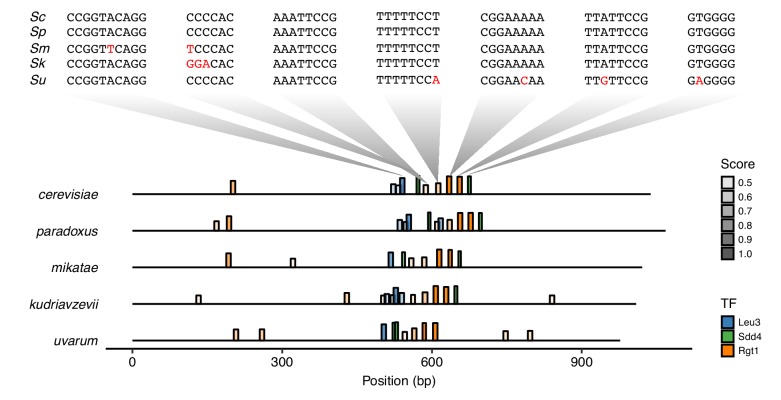
Conservation of TF motifs in HAS1pr-TDA1pr.Position of Leu3, Sdd4, and Rgt1 motifs (at least 45% of maximum possible score, using high score position weight matrix from YeTFaSCo [de Boer and Hughes, 2012]) in the intergenic region between HAS1 and TDA1 in Saccharomyces sensu stricto yeasts S. cerevisiae, S. paradoxus, S. mikatae, S. kudriavzevii, and S. uvarum (order of divergence from S. cerevisiae). Bar height and transparency both represent motif score (as fraction of maximum possible score). Above, the sequences of the regions aligning to the S. cerevisiae motifs are shown in the same vertical order, with mismatches in red.